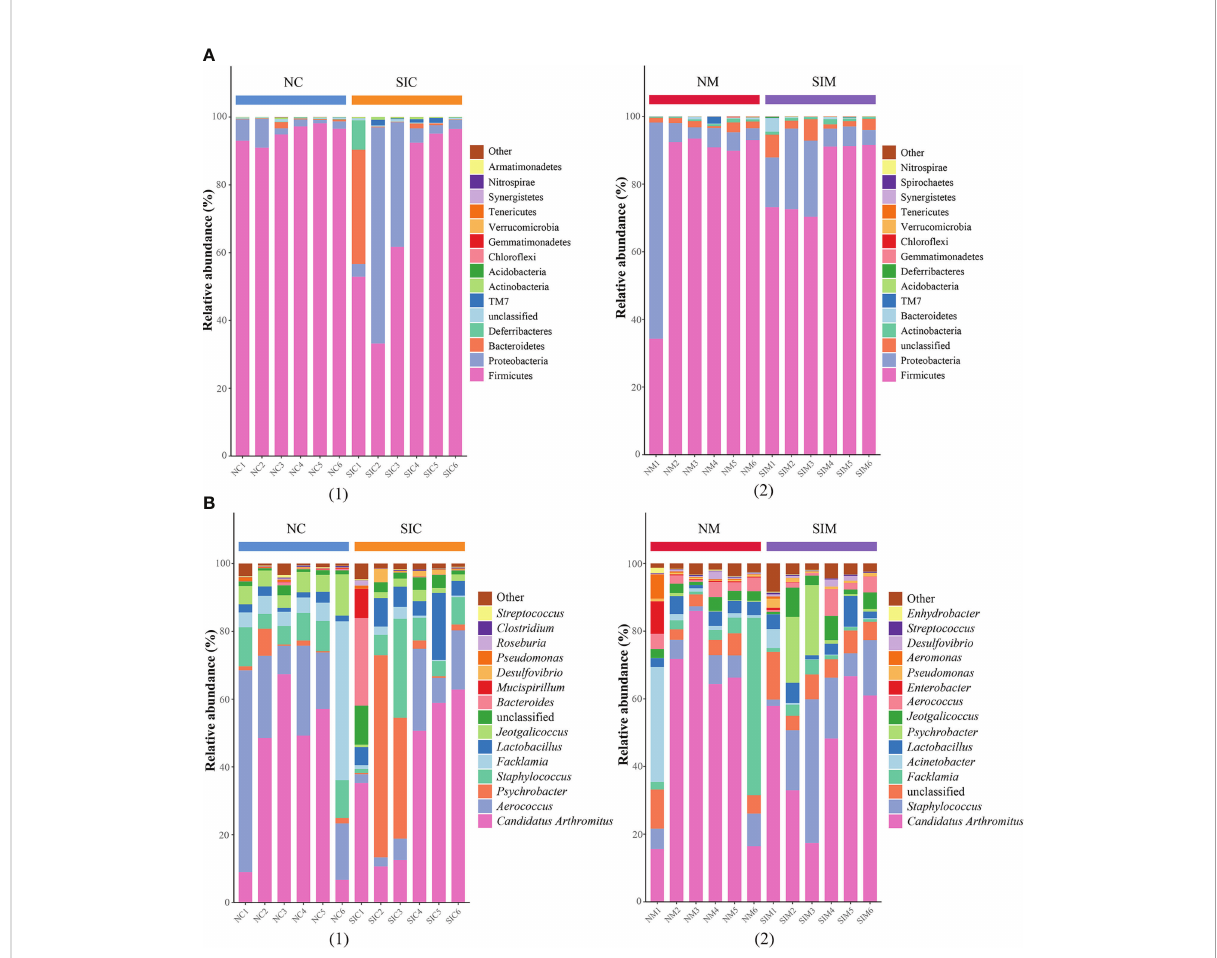
FIGURE 4 Effects of soybean iso fl avones on the gut microbiota structure of normal mice at (A) phylum and (B) genus level ( n = 6). (1) lumen-associated bacteria, (2) mucosa-associated bacteria. NC, lumen-associated bacteria of the normal group; SIC, lumen-associated bacteria of the soybean iso fl avones group; NM, mucosa-associated bacteria of the normal group; SIM, mucosa-associated bacteria of the soybean iso fl avones